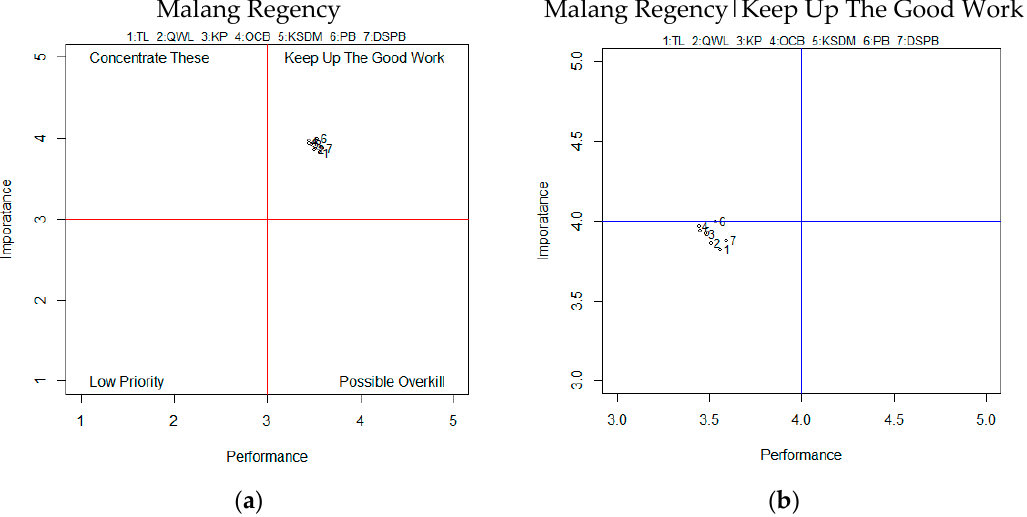
Figure 2. ( a ) IPA Cartesian Diagram of Malang Regency. ( b ) IPA Cartesian Diagram of Keep up the Good Work Quadrant of Malang Regency.